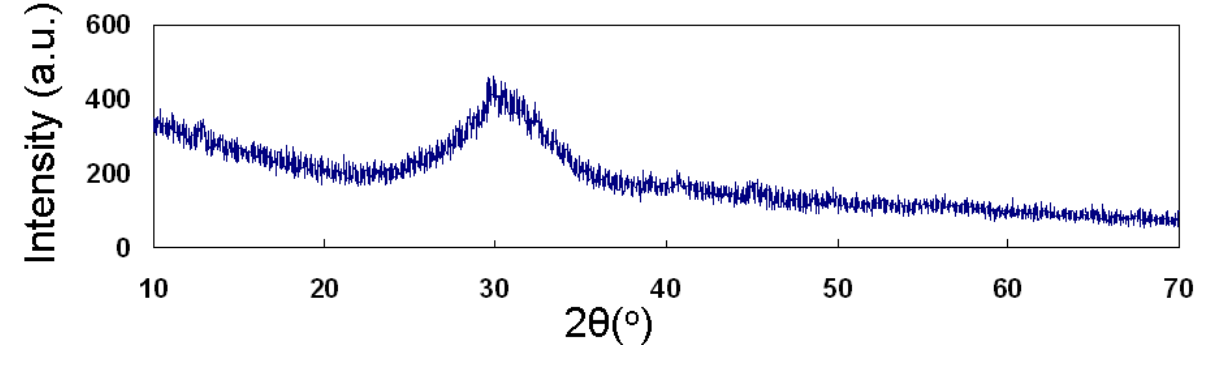
Figure 2. XRD spectra of the BG_Ca sintered sample treated at 750 °C for 3 hours.